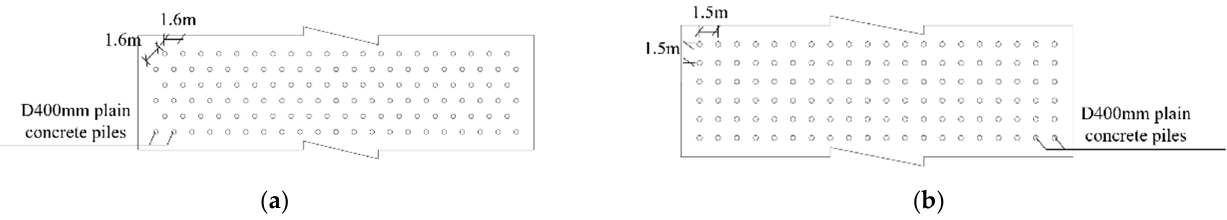
Figure 1. ( a ) Typical geotechnical profile , ( b )Finite element model and grid division.